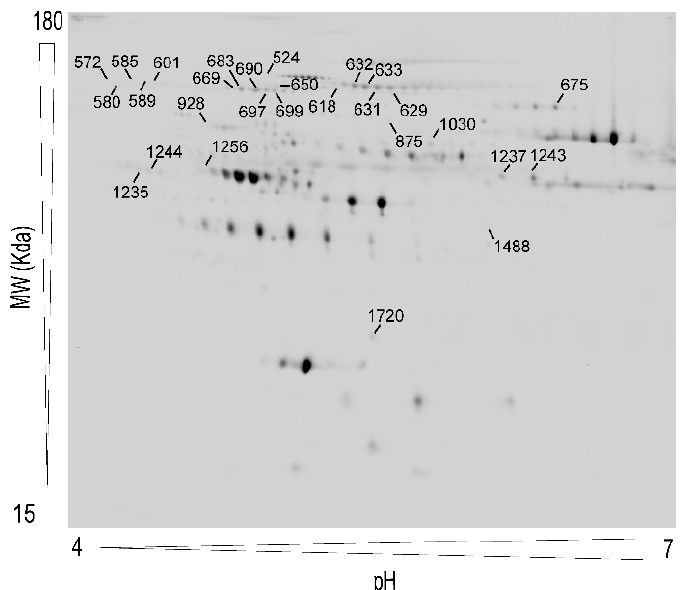
Figure 1. Representative two-dimensional differential in-gel electrophoresis (2D-DIGE) map of plasma protein extracts including the pick locations of the proteins identified in the study. The most relevant results for our aim were those resulting from the analysis of the interactions between the group of patients and the time of sampling, meaning the effect of surgically induced weight loss on protein abundance differed depending on the glucose tolerance of the obese subjects (Figure 2). We observed interactions in 14 spots from eight proteins: SERPINA3, prothrombin (F2), alpha-2-macroglobulin (A2M), fibrinogen beta chain (FBG), fibrinogen gamma chain (FGG), CP, gelsolin (GSN), and APCS. As shown in Figure 2, the abundance of SERPINA3 (spots 1235 and 1244), F2 (spot 928), and GSN (spot 1030) decreased after surgery in the non-diabetic (all spots) and diabetes remission groups (except for spot 1235), whereas no changes were observed in the persistent diabetes group. The abundance of A2M (spots 618, 631, 632, and 633), FGB (spots 1237 and 1243), and FGG (spot 1488) increased in the non-diabetic and diabetes remission groups after surgery; such an increase was not observed in patients with persistent diabetes. Moreover, the abundance of CP (spot 650) only increased in the diabetes remission group. Finally, the abundance of APCS (spot 1720) decreased after surgery in all groups, even though the magnitude of the decrease was larger in the non-diabetic and diabetes remission groups compared with the reduction observed in the persistent diabetes